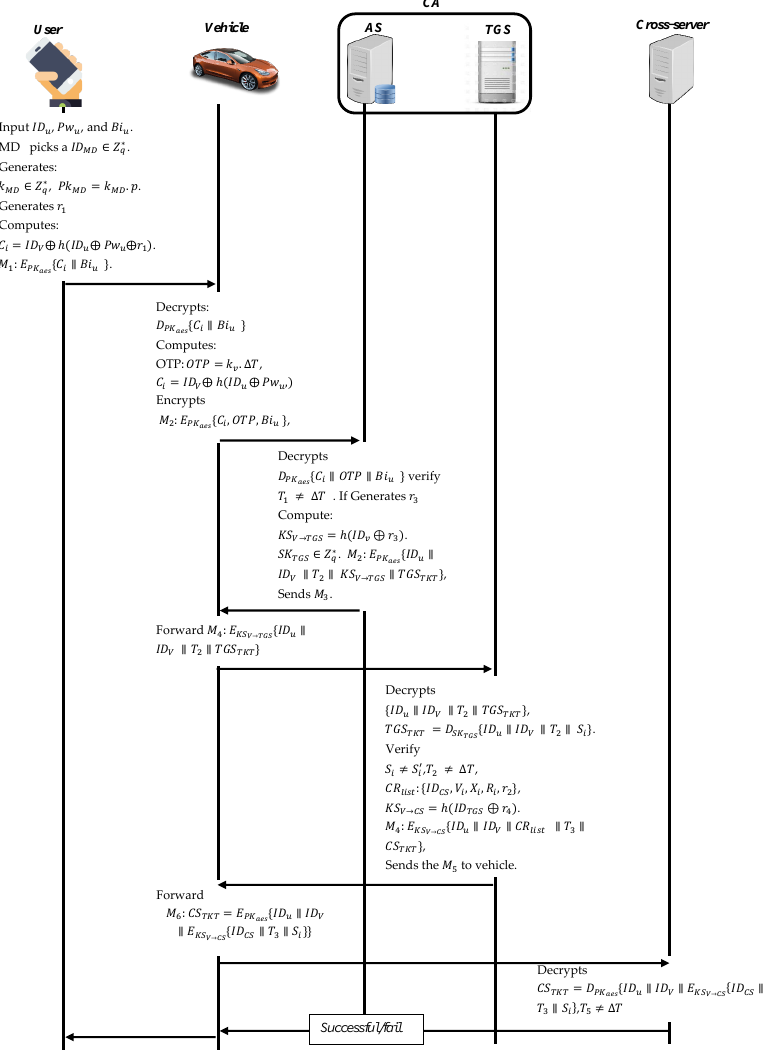
Figure 7. The online vehicle booking